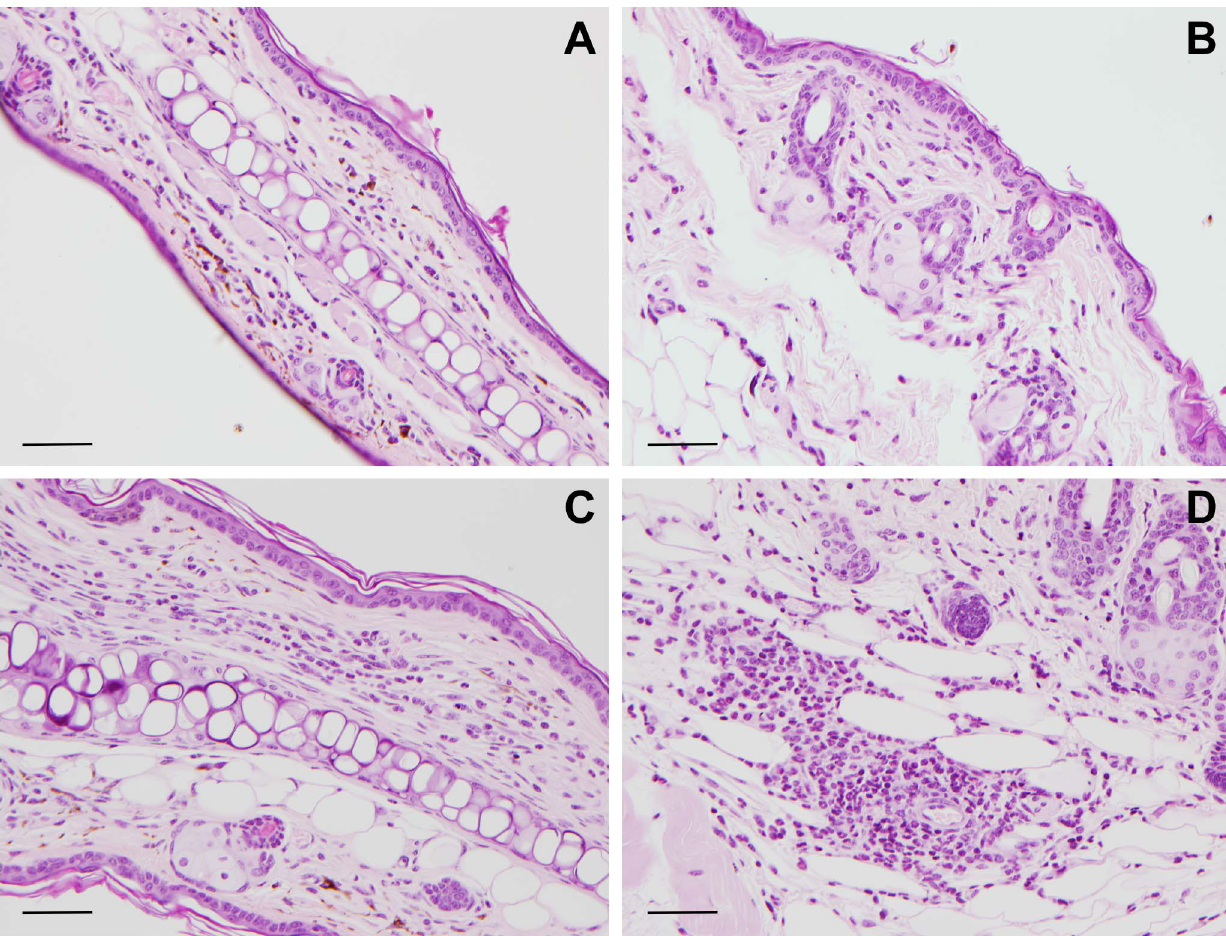
Figure 4. Histological response to flea bites in skin of mice previously exposed to fleas for ten weeks. Representative examples of skin sections from ear ( A ) and abdomen ( B ) showing minimal inflammation (score=1), and from ear ( C ) and abdomen ( D ) showing mild inflammation (score=2). Samples were from mice that had been exposed to flea bites for 10 weeks (Group B and C mice, see Table 1 and Methods for details). Four of 10 and 2 of 10 ear samples had a score of 1 or 2, respectively; 5 of 10 and 2 of 10 abdominal skin samples had a score of 1 or 2, respectively. All other samples were indistinguishable from controls. See Methods for scoring criteria. Scale bars=50 m m. (Fig. 3). At the end of their 10-week flea exposure regimen (Table 1), Group A, B and C mice were exposed to flea bites a final time on the ear. Twelve hours later the presence of neutrophils and macrophages was assessed by flow cytometry and compared to the naı¨ve mouse 12 h timepoint (Fig. 3). Total neutrophils (Ly-6G + cells) from Group C mice, a high exposure treatment, was significantly less (P , 0.05) than the response seen in the low exposure Group A (Fig. 6A). In addition, fewer activated neutrophils (Ly-6G + CD11b high cells) were present in Groups B and C than in Group A, with a statistically significant difference between Group A and B (P , 0.05, Fig. 6B). Figure 6C shows % neutrophils activated, the percentage of Ly-6G + cells also CD11b high . Group B was significantly less than both Group A (P , 0.01) and the naı¨ve mice group (P , 0.05). Finally, mice with higher exposure to fleas (Groups B and C) had a much lower macrophage response than Group A (vs. Group C: P , 0.05) or naı¨ve mice (vs. Group B: P , 0.05; vs. Group C: P , 0.001) (Fig. 6D). Overall this indicates a reduction in neutrophil and macrophage recruitment 12 h after flea feeding in experimentally exposed mice compared to naive mice receiving flea bites for the first time.